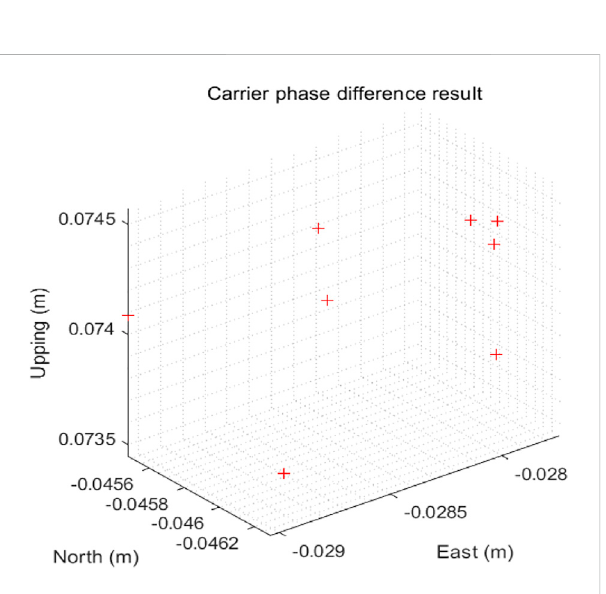
FIGURE 11 Plot of carrier phase differential positioning